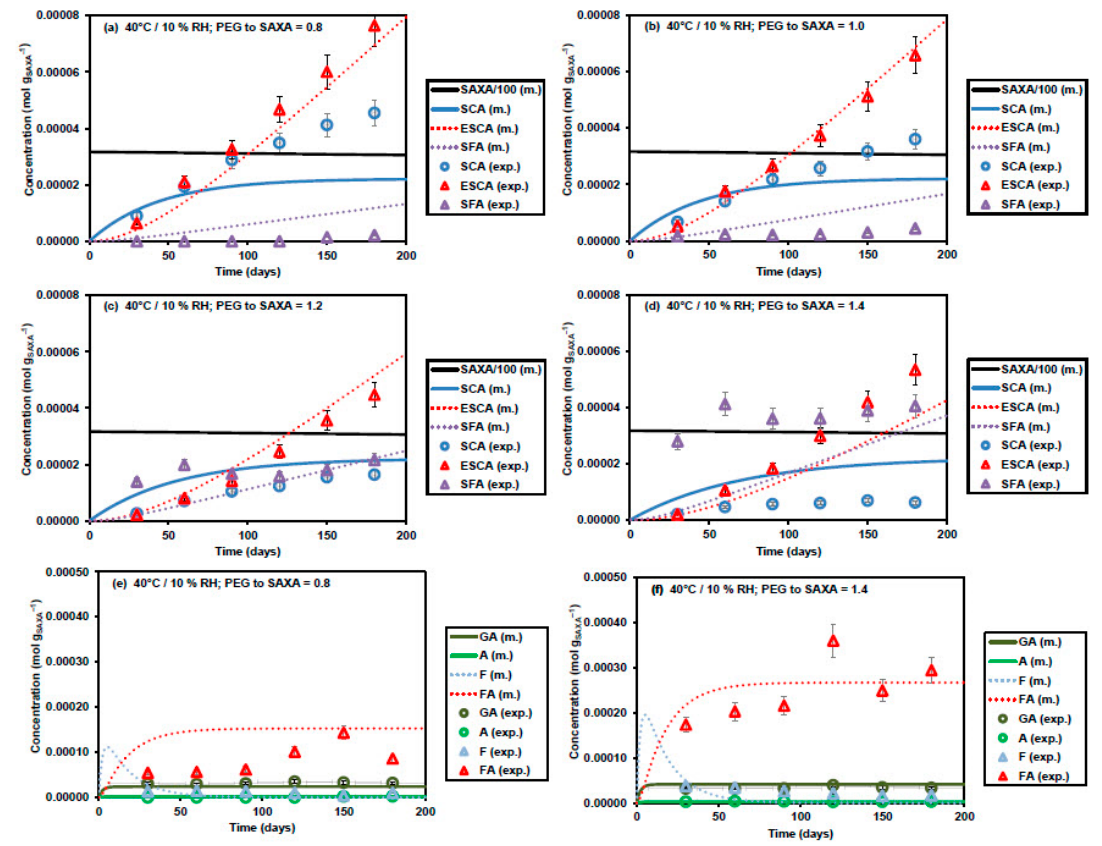
Figure 6. The concentration of saxagliptin (SAXA) degradation products (amidine (SCA), epimer (ESCA) and formyl amide (SFA)) ( a – d ) or polyethylene glycol polymer (PEG) (glycolic acid (GA), acetaldehyde (A), formaldehyde (F) and formic acid (FA)) ( e – f ) reactions. Lines represent fitted model (m.), markers experimental data points (exp.). Tablet degradation tests were executed at the temperature of 40 ◦ C, the nominal water activity of 10% and the initial polyethylene glycol (PEG) to SAXA weight ratios of 0.8 ( a , e ), 1.0 ( b ), 1.2 ( c ) and 1.4 ( d , f ). A relative error of 10% is set based on sum of